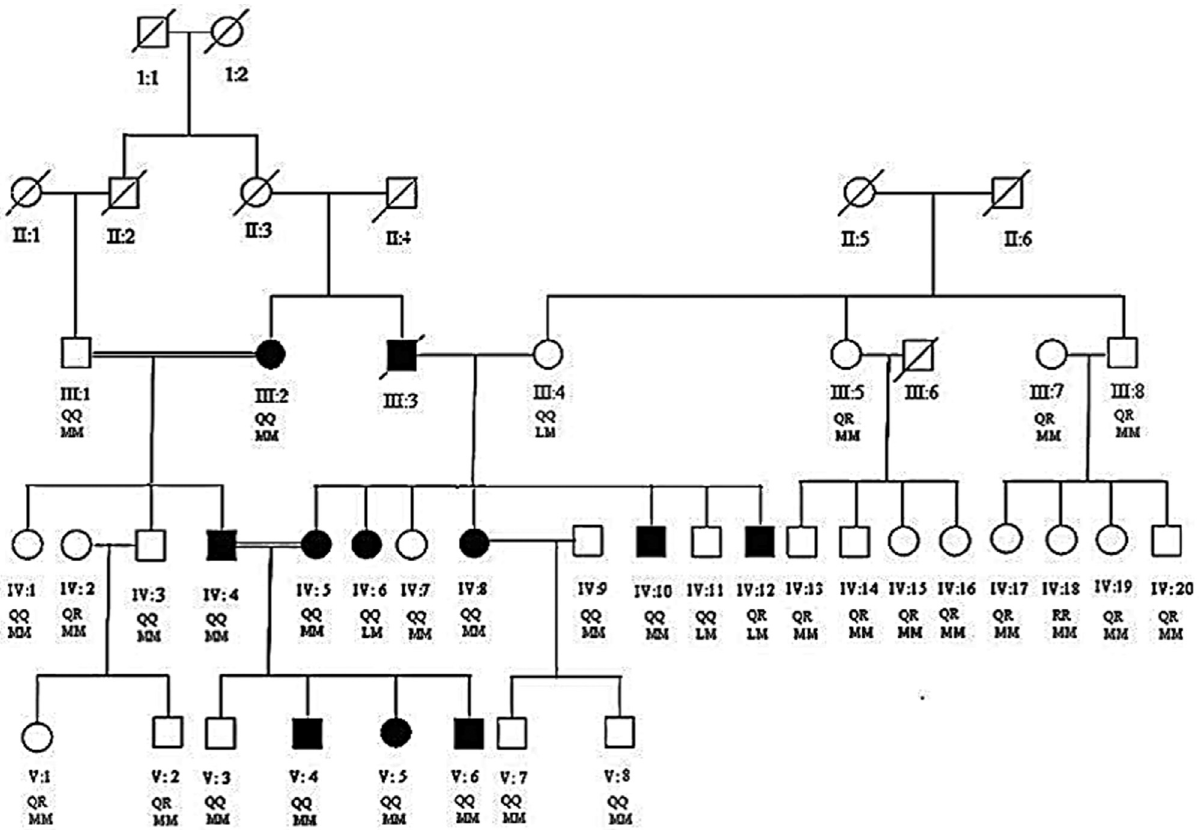
Figure 1 - Pedigree of hypercholesterolemia family. Filled boxes and circles represent male and female patients respectively. Empty boxes and circles represent male and female carriers respectively. Modified from Ajmal et al.